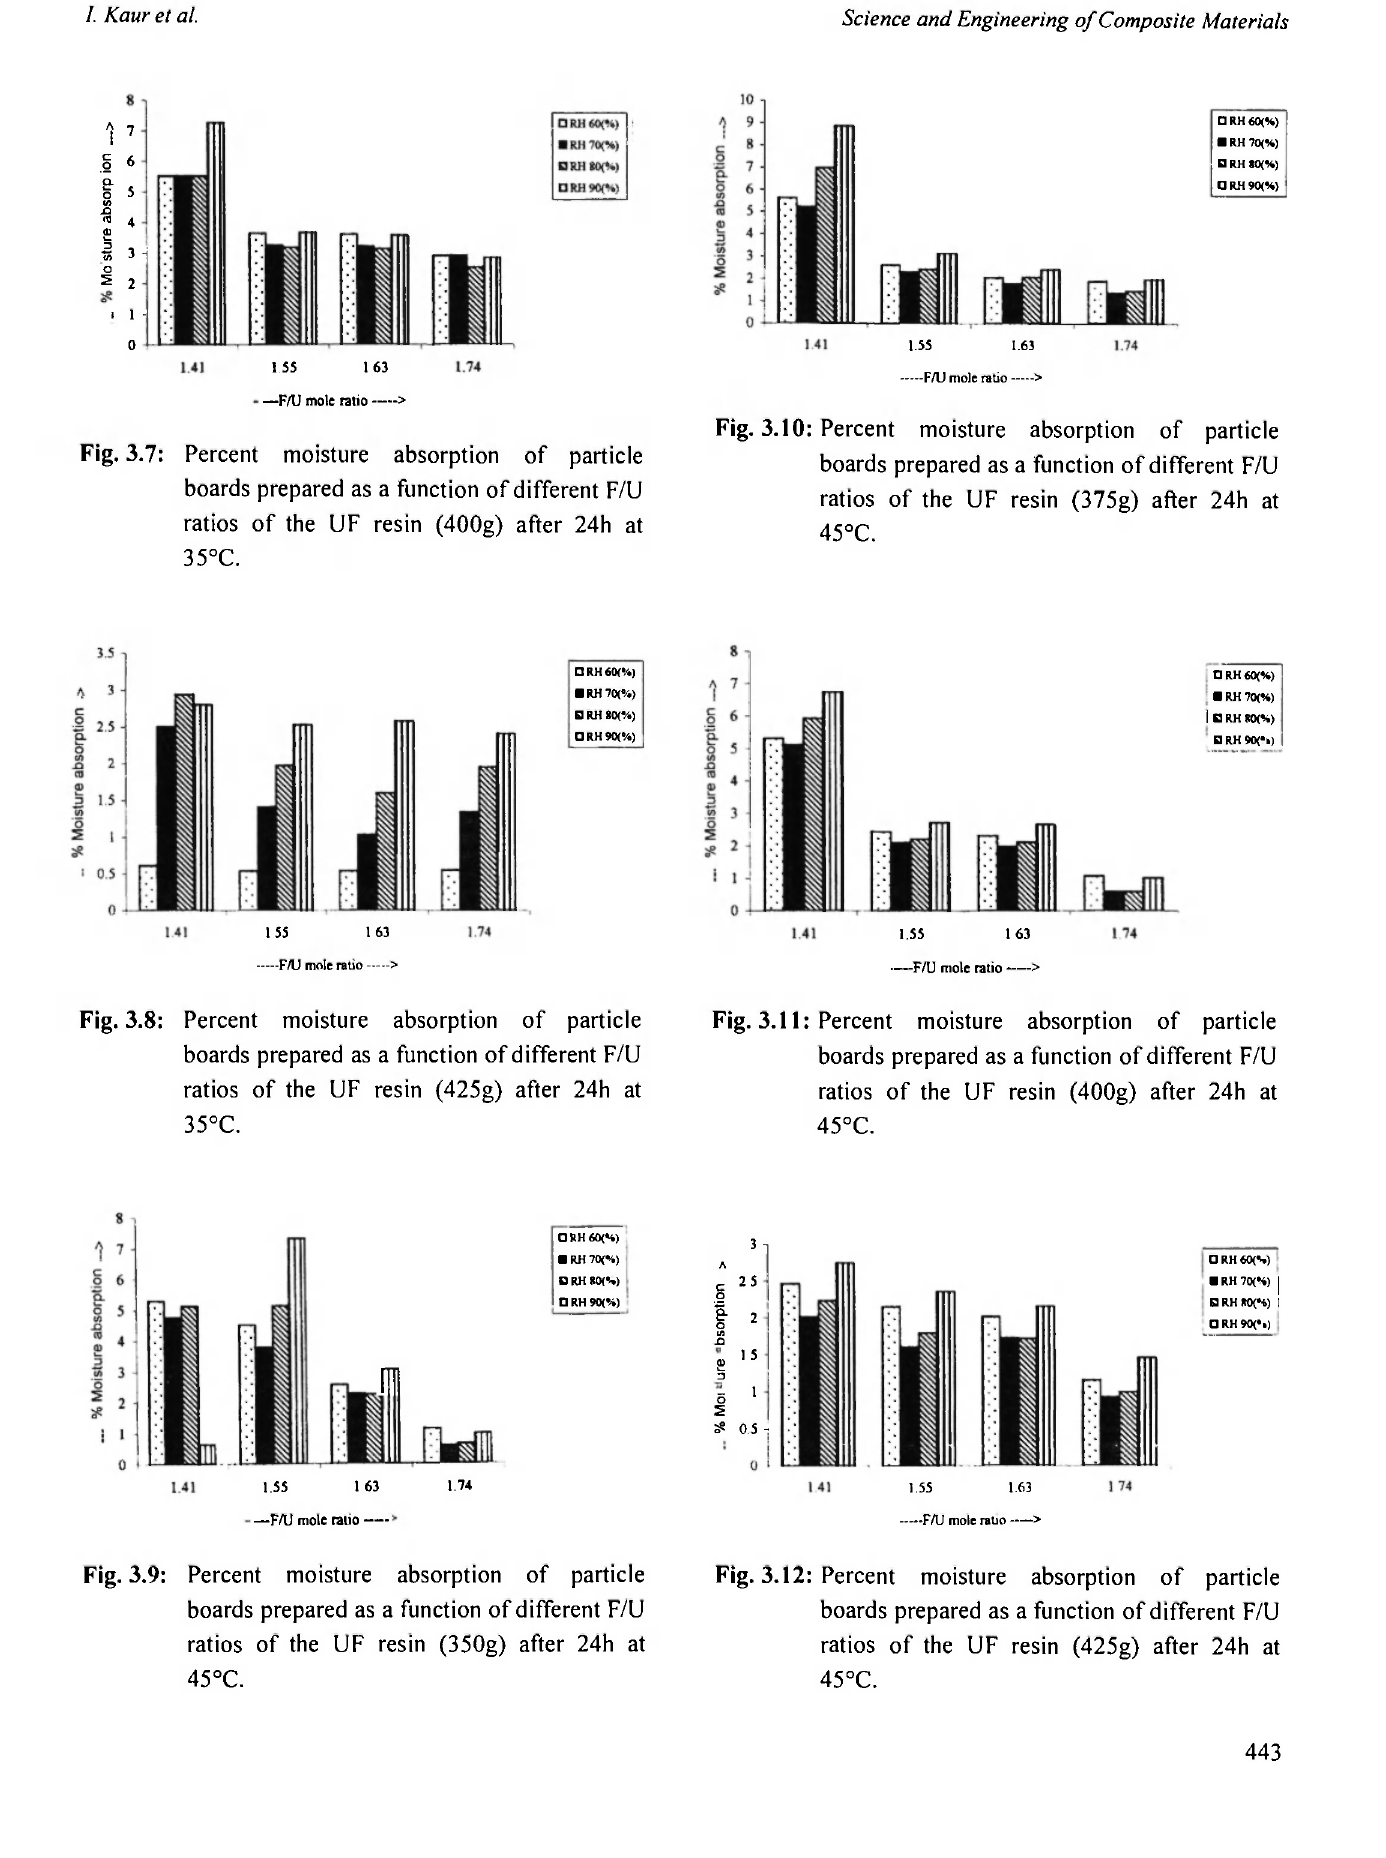
Fig. 3.12: Percent moisture absorption of particle boards prepared as a function of different F/U ratios of the UF resin (425g) after 24h at